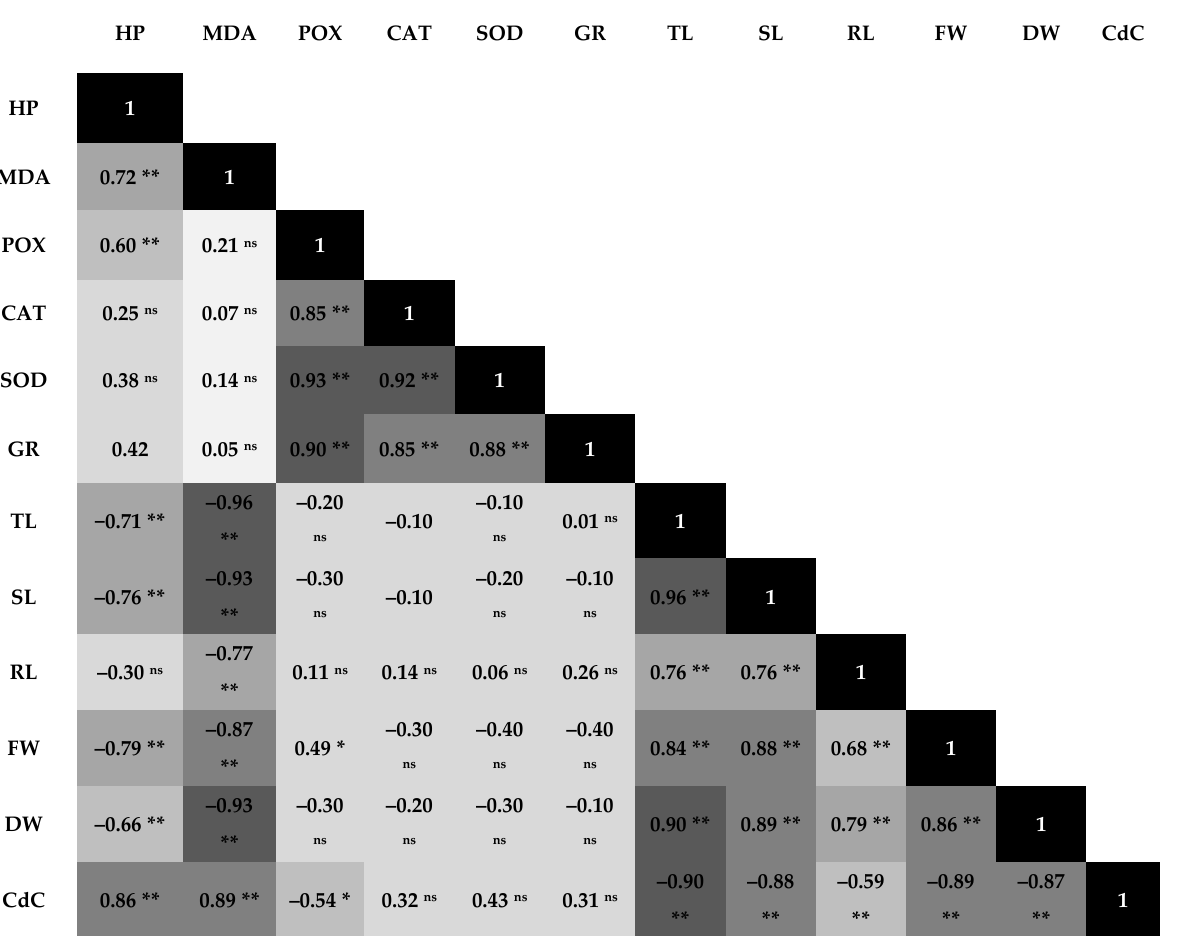
Figure 4. Correlation matrix of different traits under Cd-rich conditions, ns non-significant, * significant at p < 0.05, ** significant at p < 0.01. HP: hydrogen peroxide, MDA: malondialdehyde, POX: peroxidase, CAT: catalase, SOD: superoxide dismutase, GR: glutathione reductase, TL: total length, SL: shoot length, RL: root length, FW: fresh weight, DW: dry weight, CdC: Cd content. Color intensity increases with increasing correlations between traits.